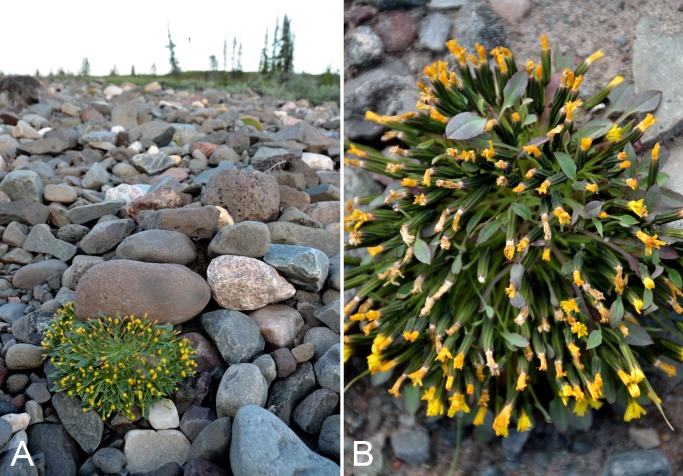
Askellia pygmaea.(A) Habitat, Saarela et al. 3450. (B) Habit, Saarela et al. 3962. Photographs by R. D. Bull.